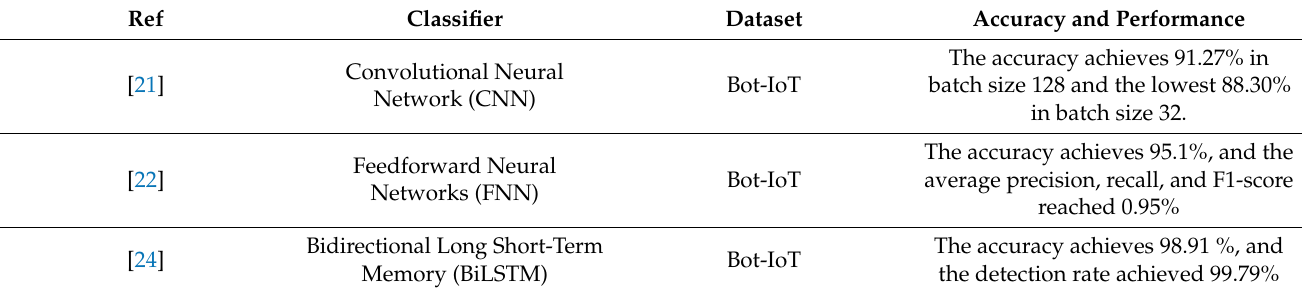
Figure 3. Experiment results for precision, recall and F1 score.